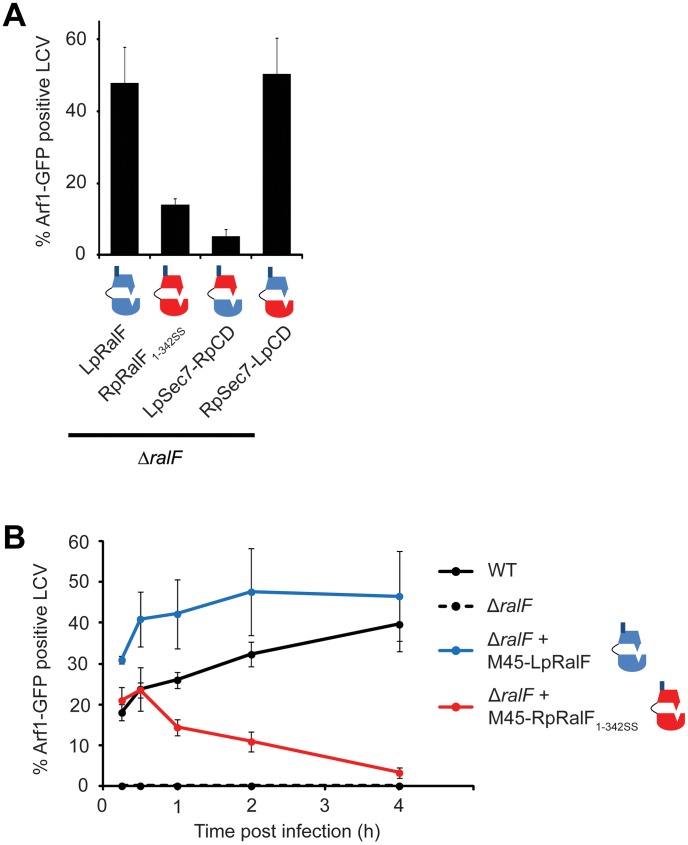
RalF capping domain is the critical determinant for efficient Arf1 recruitment.
A) HEK293 cells stably expressing Arf1-GFP were infected with L. pneumophila ΔralF complemented with the indicated constructs. Arf1-GFP recruitment to the LCV was quantified 1 h post-infection. Represented is the average of 3 experiments where 50 vacuoles were counted. Standard deviations are indicated. B) Kinetics of Arf1-GFP recruitment to the LCV by Legionella wt, ΔralF, or ΔralF expressing M45-LpRalF or M45-RpRalF1–342SS. Represented is the average of 3 experiments where 50 vacuoles were counted. Standard deviations are indicated.